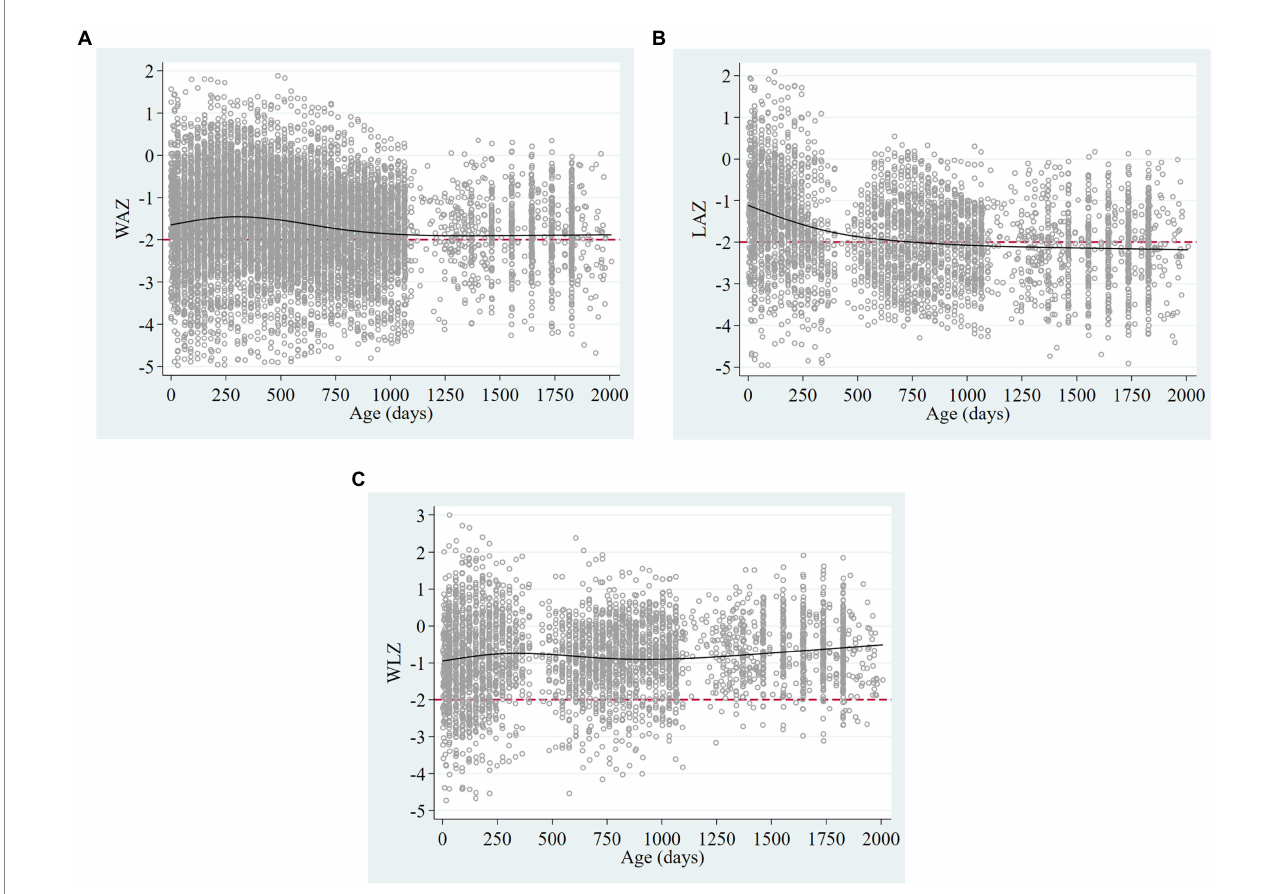
FIGURE 3 Scatter plots of (A) weight for age, (B) length/height, and (C) weight for length/height Z-scores, showing restricted cubic splines (solid black lines) and the cut-off of − 2 standard deviations (dashed red lines) in children 0–5 years in the MAL-ED cohort of Pakistan.